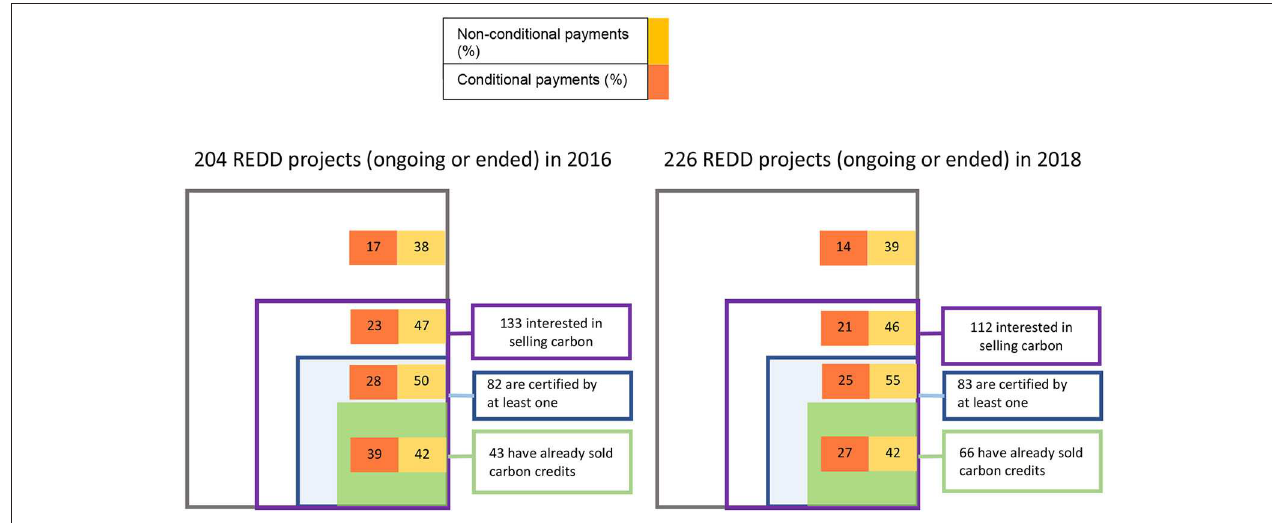
FIGURE 5 | Certification, carbon sales and types of incentive payments planned in REDD projects: status in 2016 and 2018 compared.